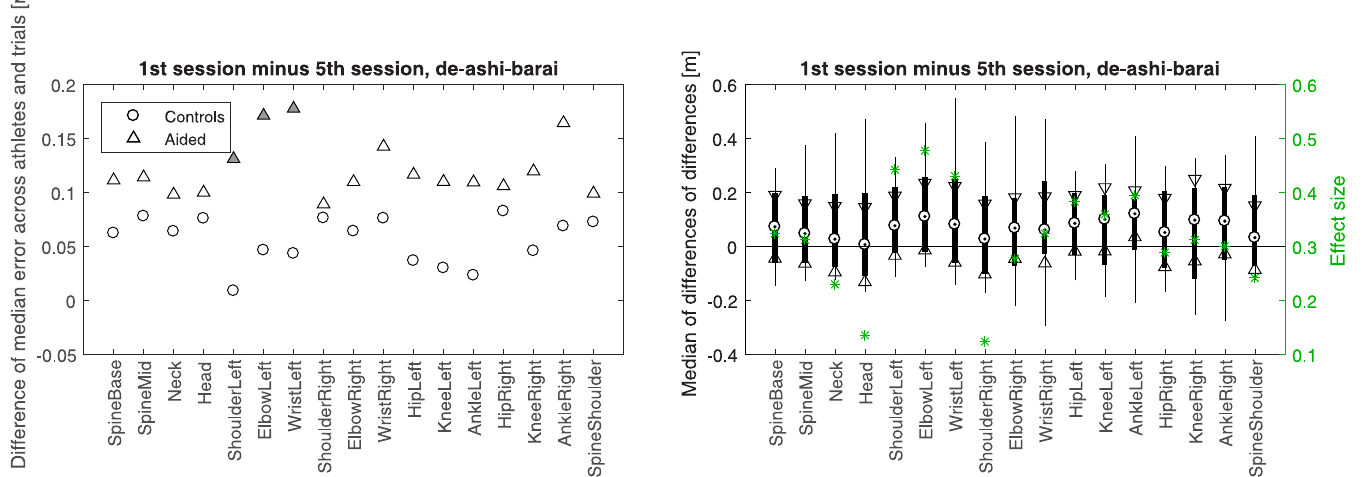
Fig 8. The difference of Controls’ performance in their 1st and 5th session vs the corresponding difference of Aided, for de-ashi-barai . For better readability, scales are different than those in Figs 4–6.